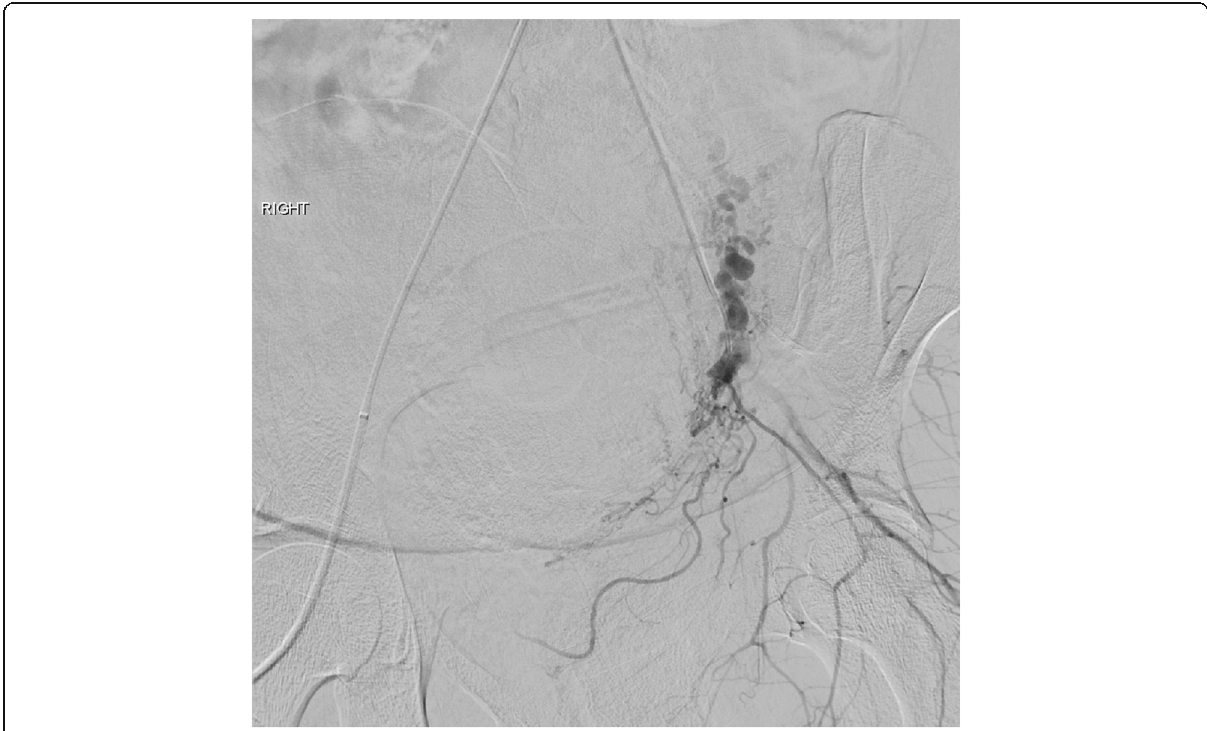
Fig. 2 Dilated uterine arteries without evidence of active extravasation in a case of uterine